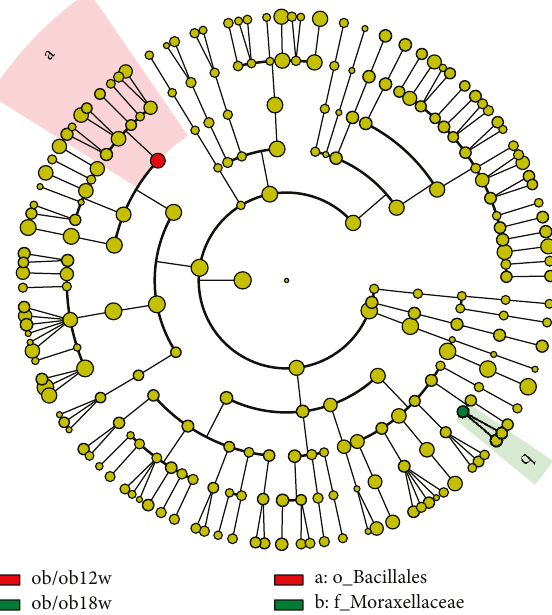
Figure 4: Cladogram representing a signi fi cantly high abundance of taxa in the gut microbiota of ob/ob mice at 12 and 18 weeks of age.